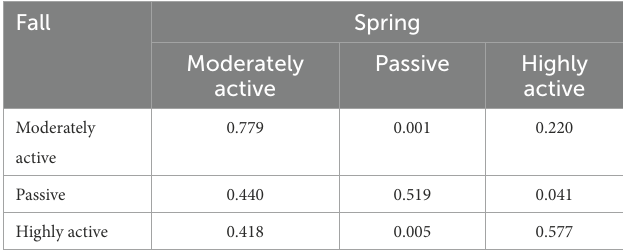
TABLE 3 Latent transition probabilities between profiles across Fall and Spring.